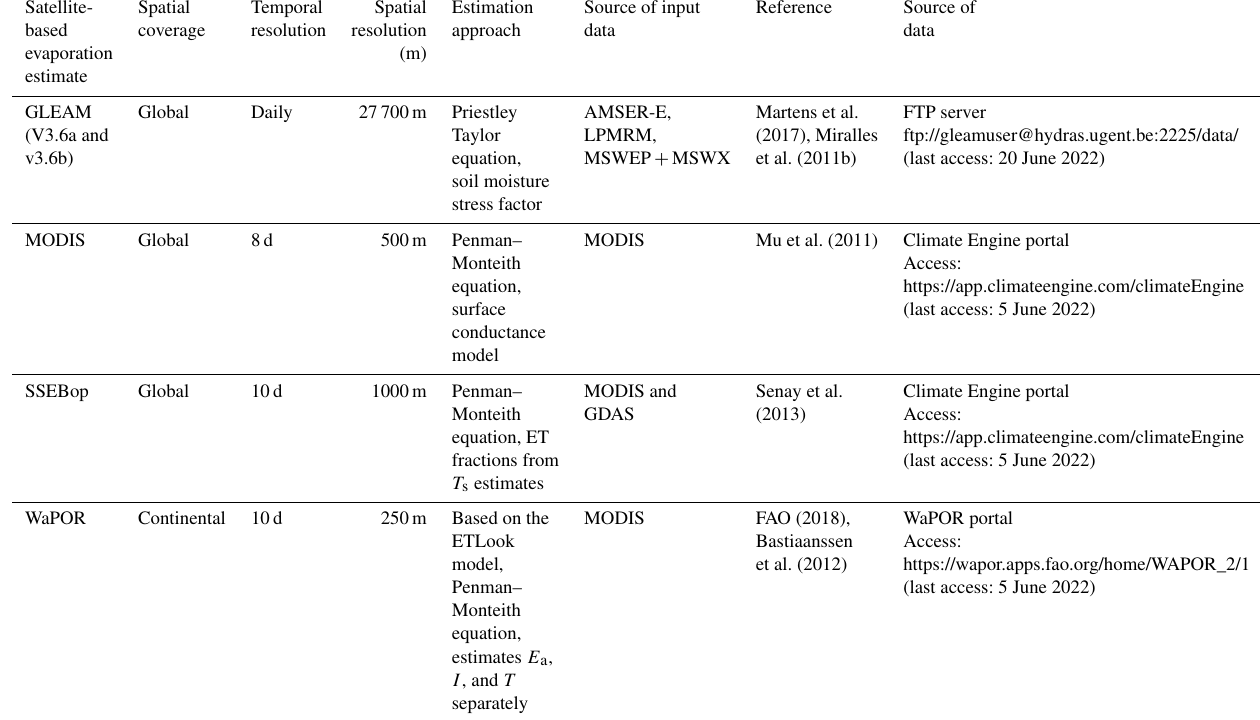
Table 1. Characteristics of satellite evaporation products used in this study. Satellite- Spatial Temporal Spatial Estimation Source of input Reference Source of based coverage resolution resolution approach data data evaporation (m) estimate GLEAM Global Daily